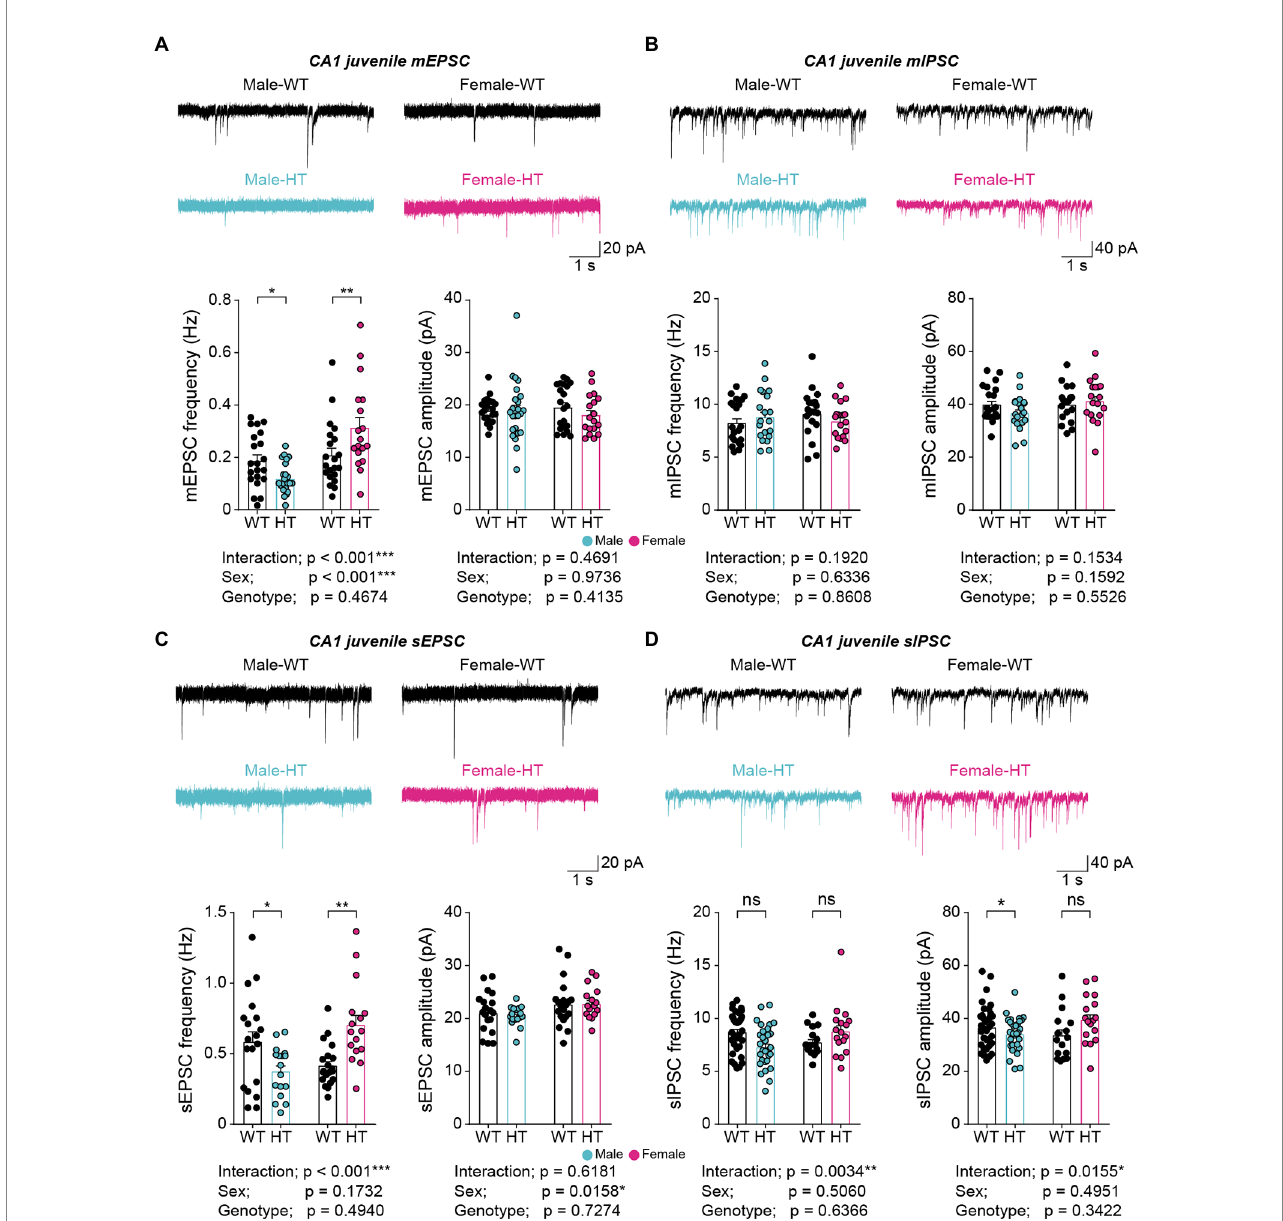
FIGURE 2 Opposite changes in excitatory synaptic transmission in juvenile Chd8+/S62X males and females. (A) mEPSCs in CA1 pyramidal neurons in juvenile Chd8 +/ S62X males and females (P25–28). ( n = 21, 6 [male-WT], 24, 6 [male-HT], 21, 4 [female-WT], and 18, 4 [female-HT], * p < 0.05, ** p < 0.01, *** p < 0.001, two-way ANOVA with Holm-Sidak test). (B) mIPSCs in CA1 pyramidal neurons in juvenile Chd8 +/S62X males and females (P22–28). ( n = 21, 4 [male-WT], 19, 4 [male- HT], 20, 4 [female-WT], and 18, 4 [female-HT], two-way ANOVA). (C) sEPSCs in CA1 pyramidal neurons in juvenile Chd8 +/S62X males and females (P22–28). ( n = 19, 4 [male-WT], 17, 4 [male-HT], 20, 4 [female-WT], and 16, 3 [female-HT], * p < 0.05, ** p < 0.01, *** p < 0.001, two-way ANOVA with Holm-Sidak test). (D) sIPSCs in CA1 pyramidal neurons in juvenile Chd8 +/S62X males and females (P22–28). ( n = 35, 5 [male-WT], 31, 5 [male-HT], 16, 3 [female-WT], and 17, 3 [female-HT], * p < 0.05, ** p < 0.01, ns, not significant, two-way ANOVA with Holm-Sidak